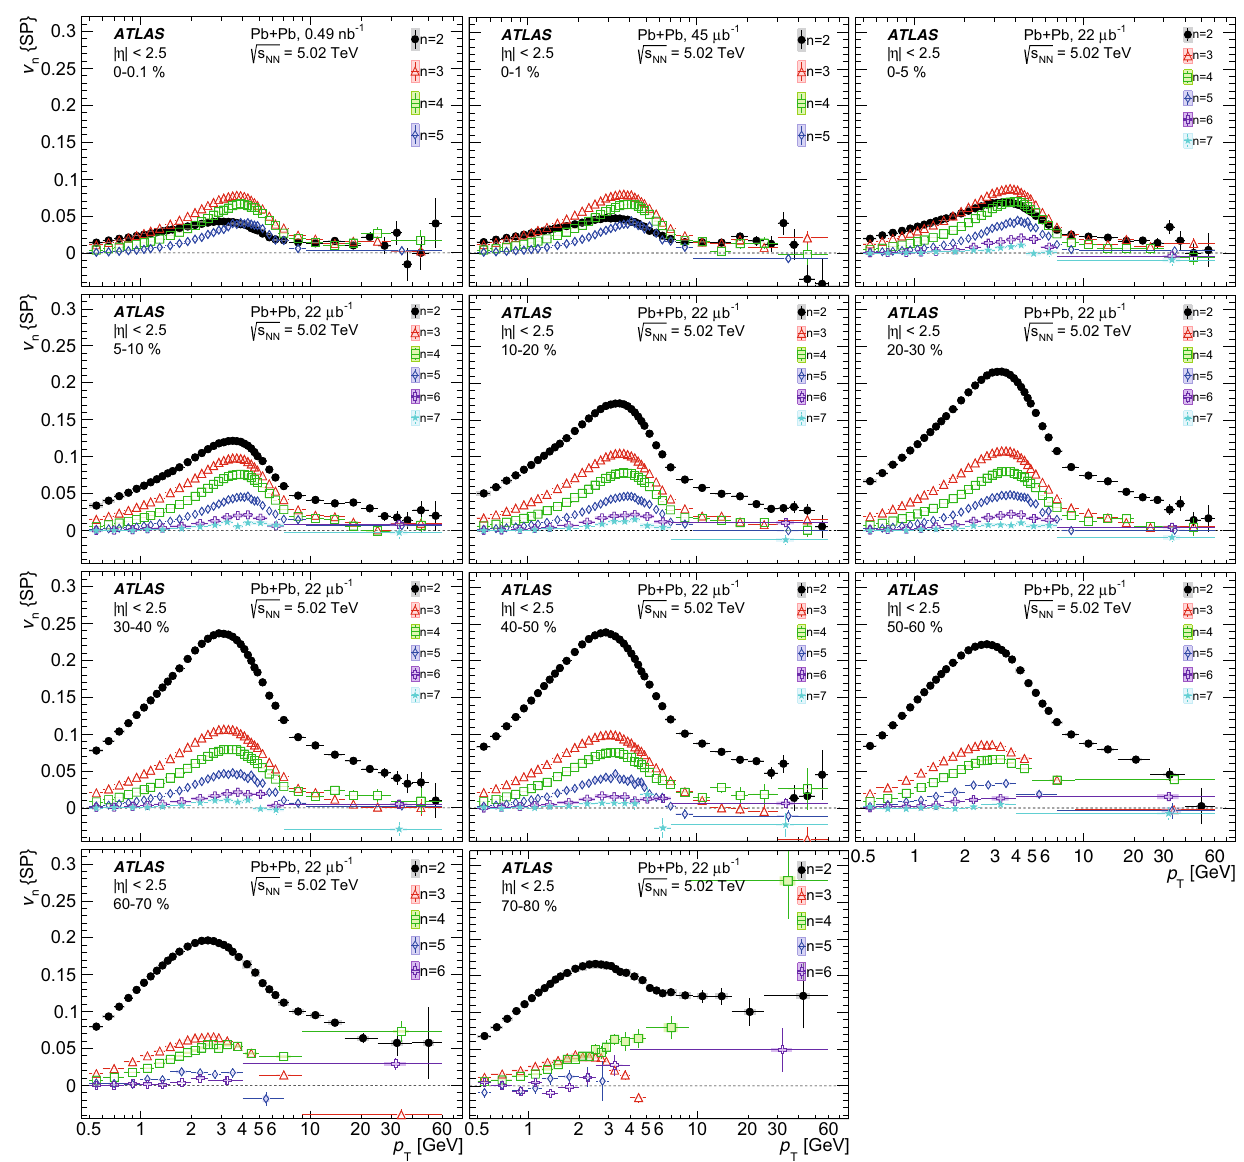
Fig. 5 The v n obtained with the SP method as a function of transverse momentum p T ,integratedover | η | < 2 . 5in11centralityintervals,from the most central at the top left panel to the most peripheral at the bottom